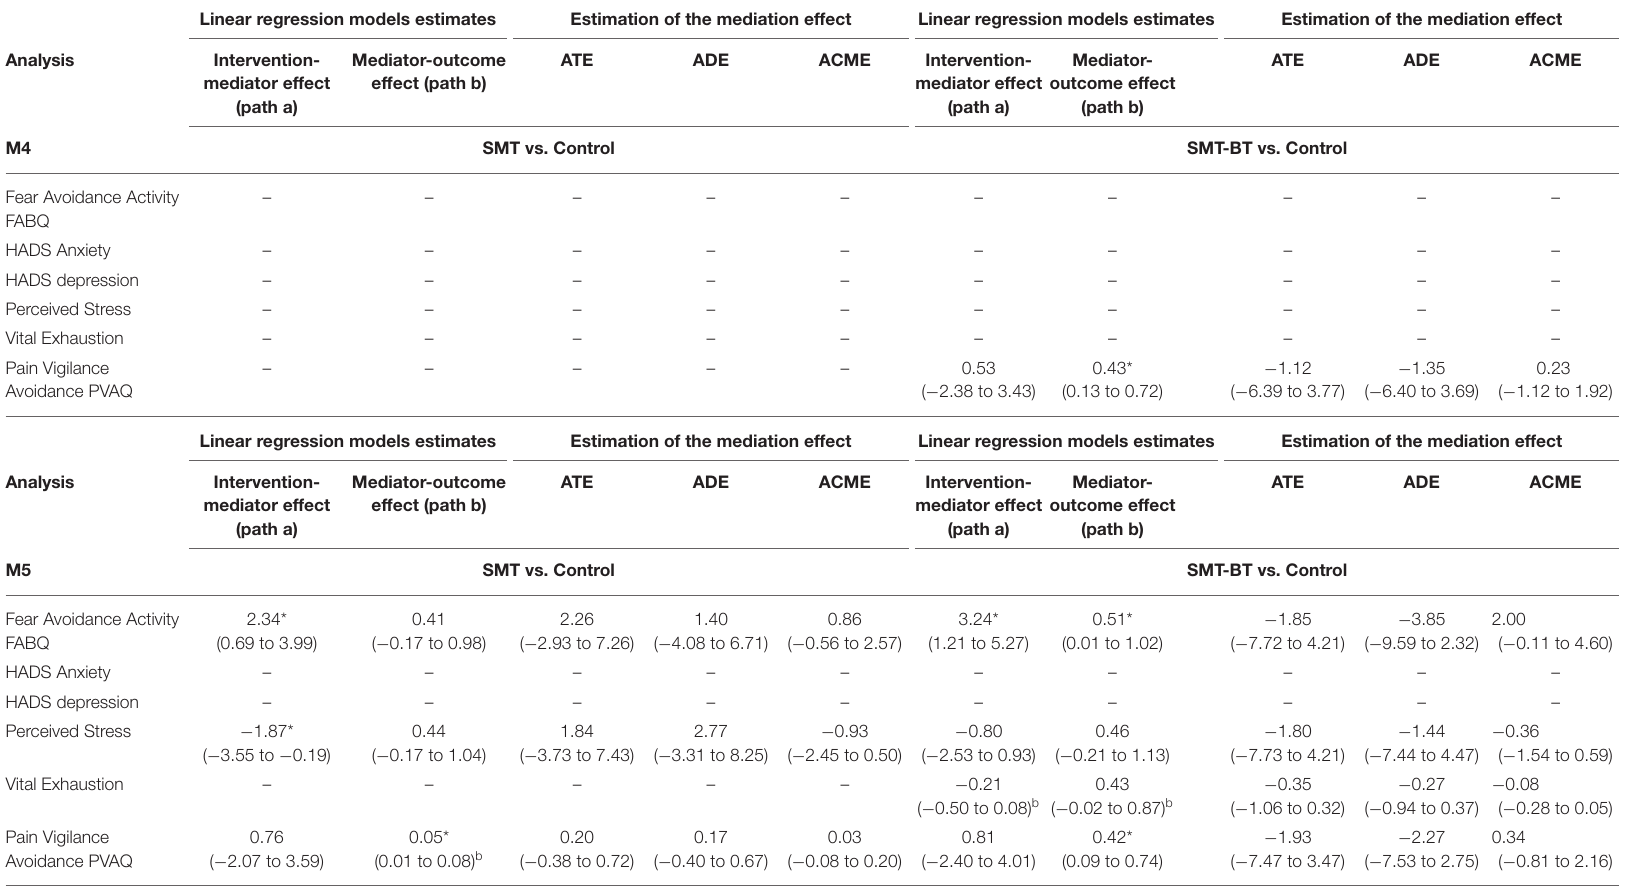
TABLE 5 | Effect decomposition for each single-mediator